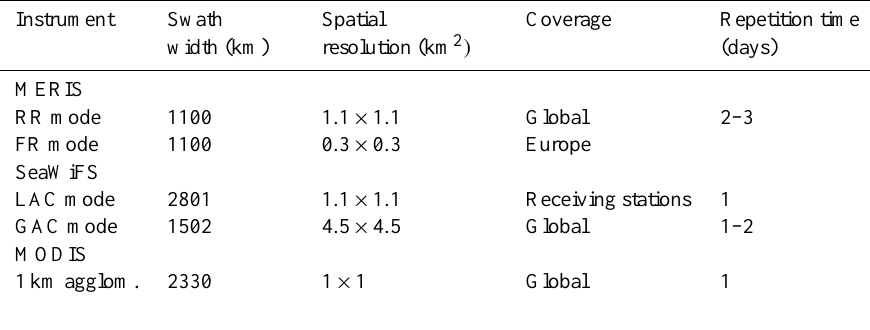
Table 2. Observation characteristics of the instruments. Instrument